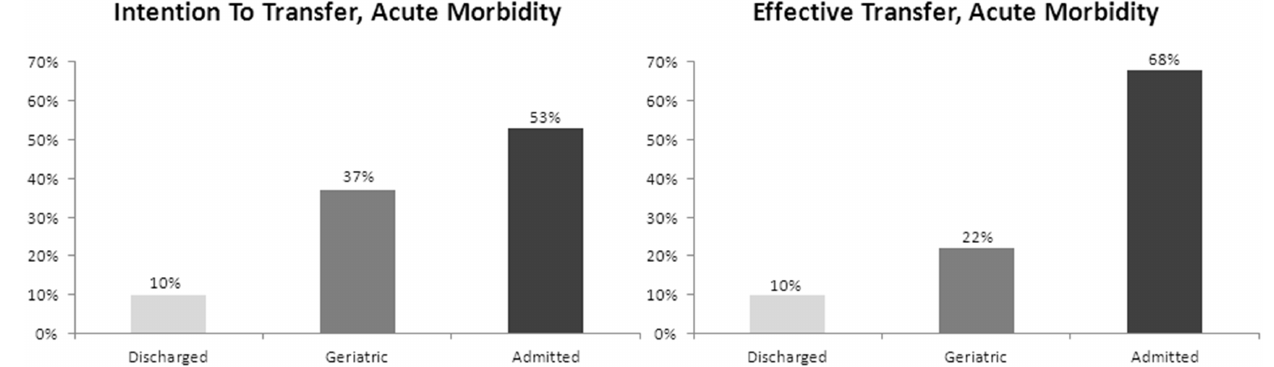
Figure 2. Modification of disposition plan in patients with acute morbidity after observation time of up to 24 hours, shown for discharged, transferred to geriatric hospital and admitted